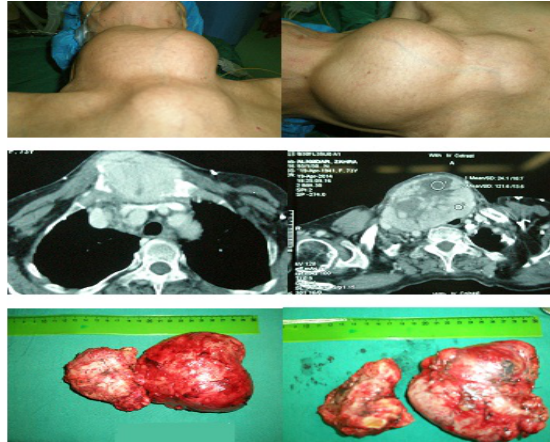
Figure2: Metastase of thyroid cancer to sternum, and resection of manubrium and sternum, reconstitution with mesh (without cement) Conflict of interest: